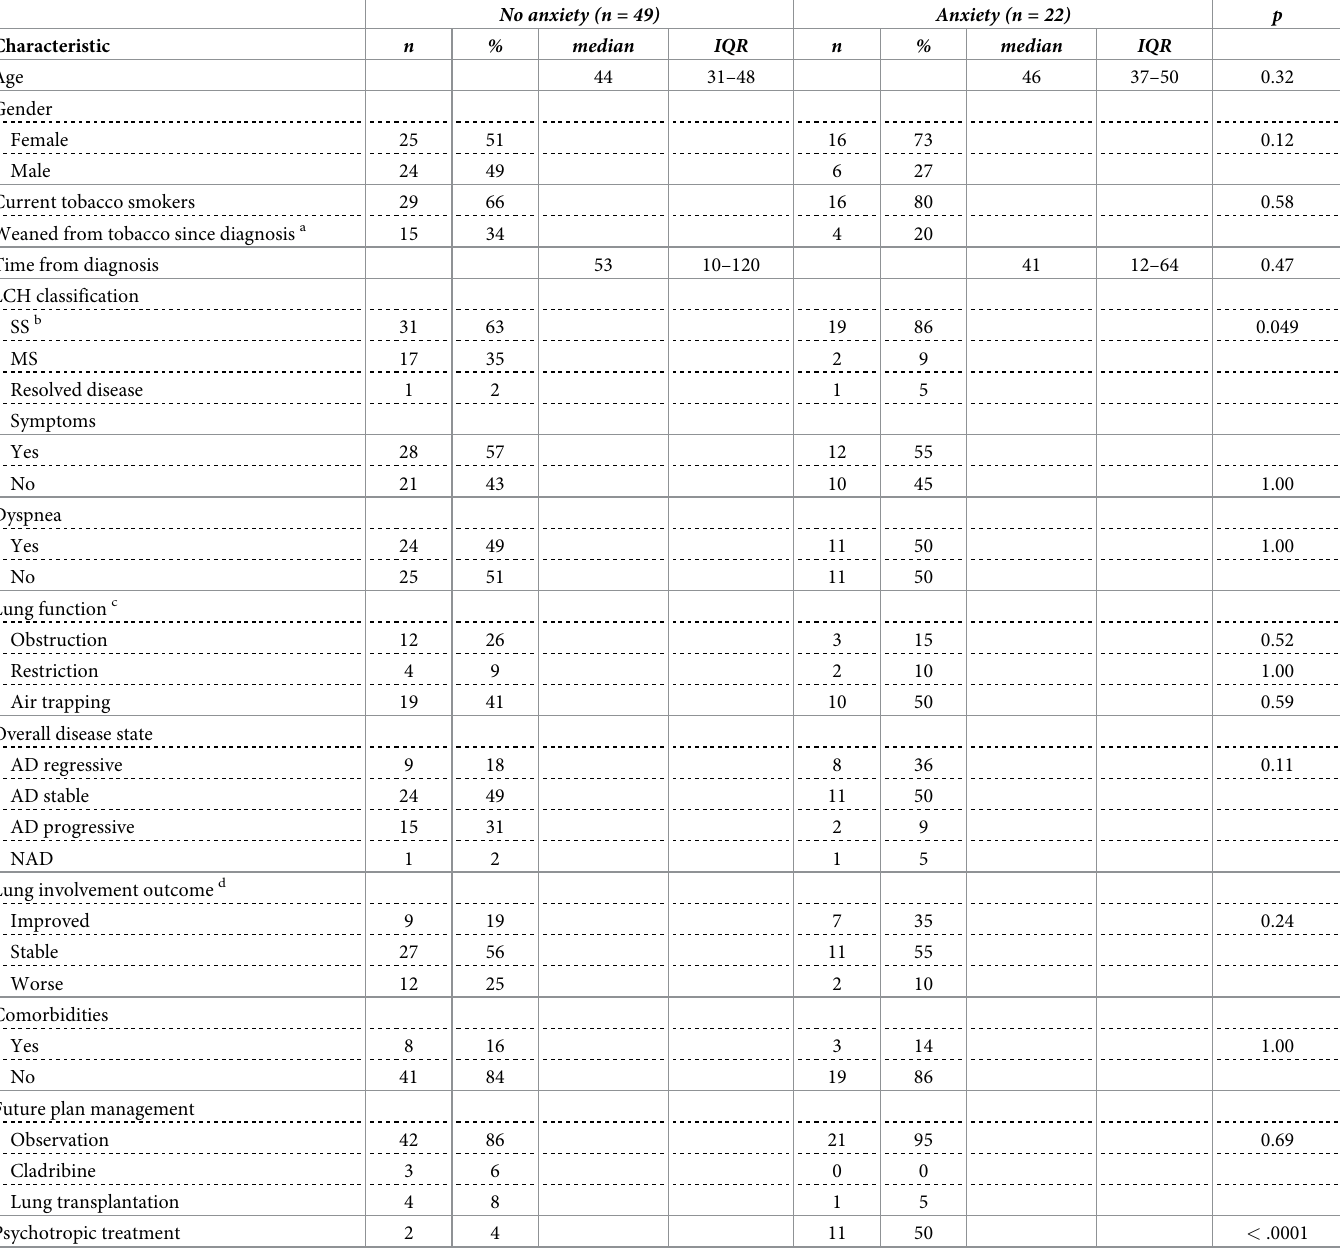
Table 4. Univariate analyses of the factors associated with clinically significant anxiety symptoms in the study population at the time of evaluation. No anxiety (n =